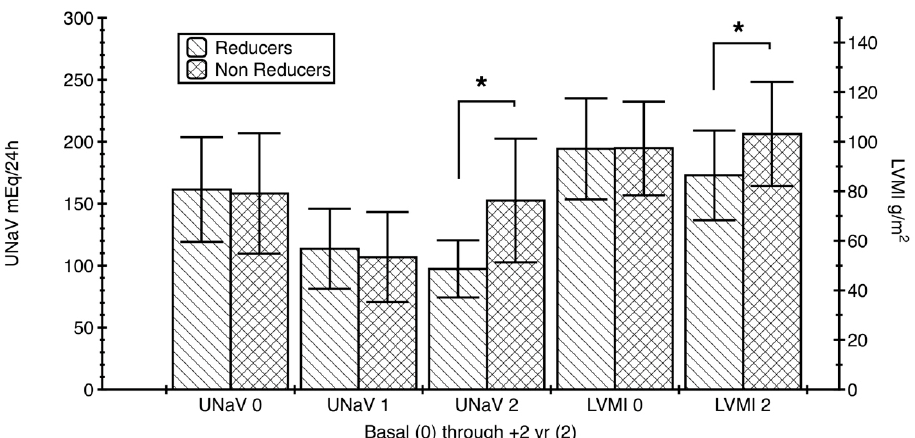
Figure 3. Left ventricular mass index and 24-h sodium excretion modifications in the two groups of patients. Figure 3 Legend: Reducers ( n = 76) had a significant LVMI decrease (two-tailed Student’s t test p < 0.001), while Non-Reducers ( n = 62) had a significant increase (two-tailed Student’s t test p < 0.001) of their LVMI over the observation period (2 years). All this was paralleled by the changes of